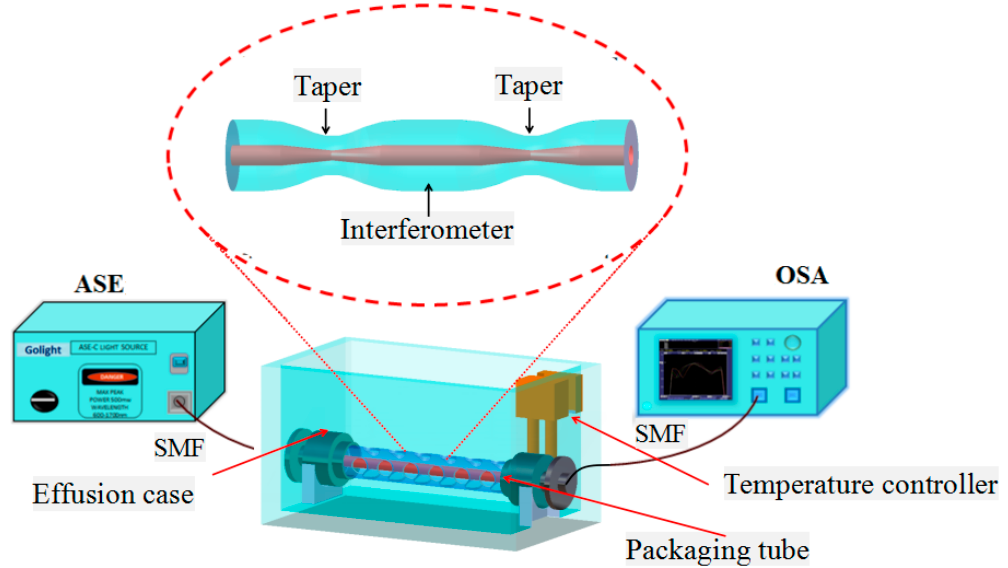
Figure 6. Laboratory equipment schematic of refractive index sensing system.